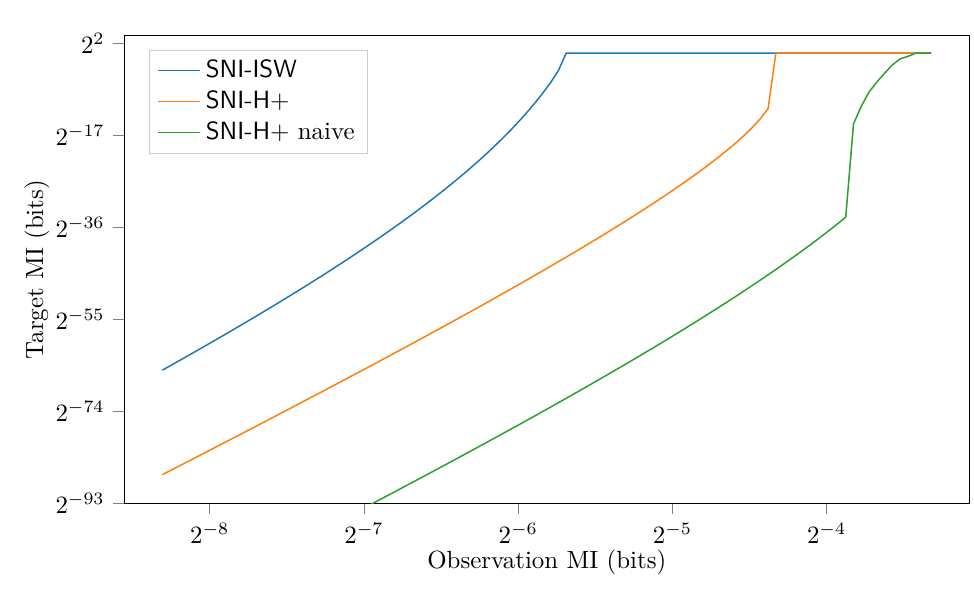
Figure 10: Target MI as a function of observation MI, for the SNI-H+ multiplication gadget at order t = 15. For the SNI-H+ naive curve, the target MI is extracted through the sums of the input and output shares only (naive attack). For the SNI-H+ curve, the improved attack is considered (equations about sums of refresh input/outputs are added. The SNI-ISW curve (which is the same for both attacks) is shown as a reference